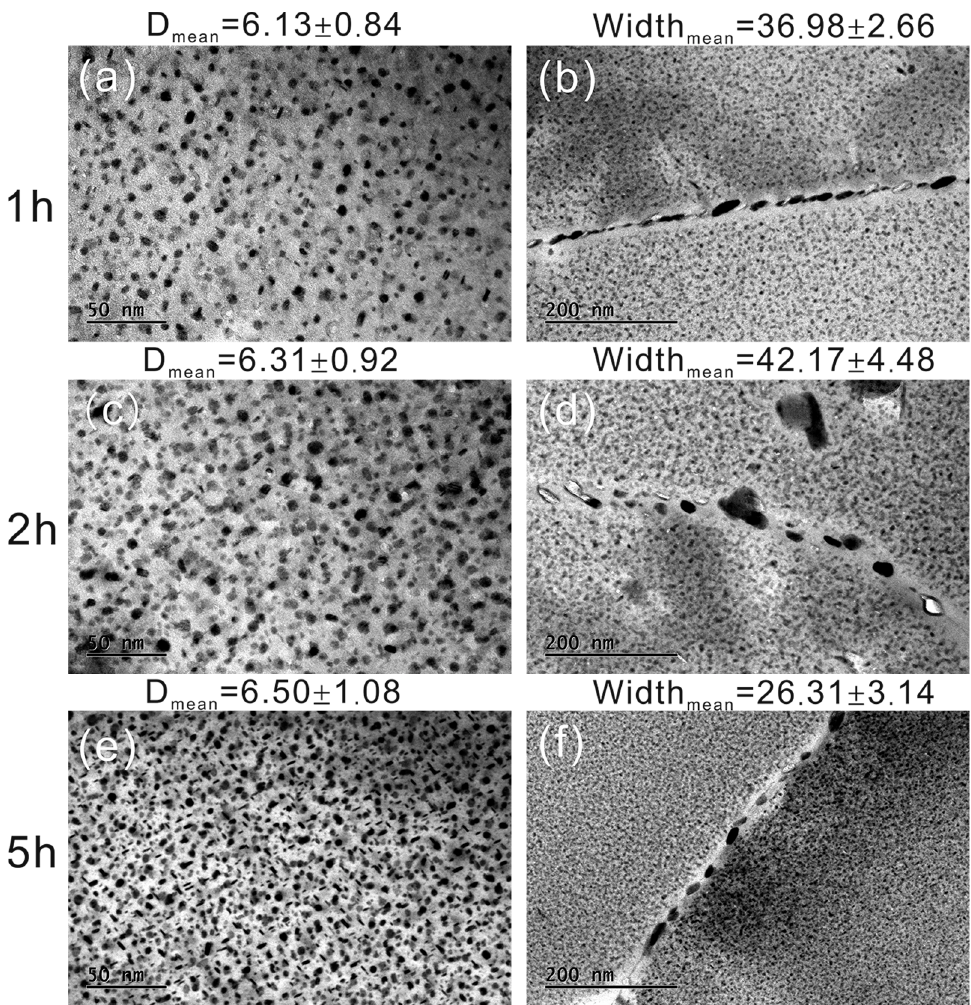
Figure 5. The age-hardening precipitates of RRA treated samples, ( a , b ) retrogression for 1 h, ( c , d ) retrogression for 2 h, and ( e , f ) retrogression for 5 h. The first column represents the precipitate within grains, the second column represents the precipitates on the grain/subgrain boundaries, and the third column shows the statistical analysis of the precipitates within grains.